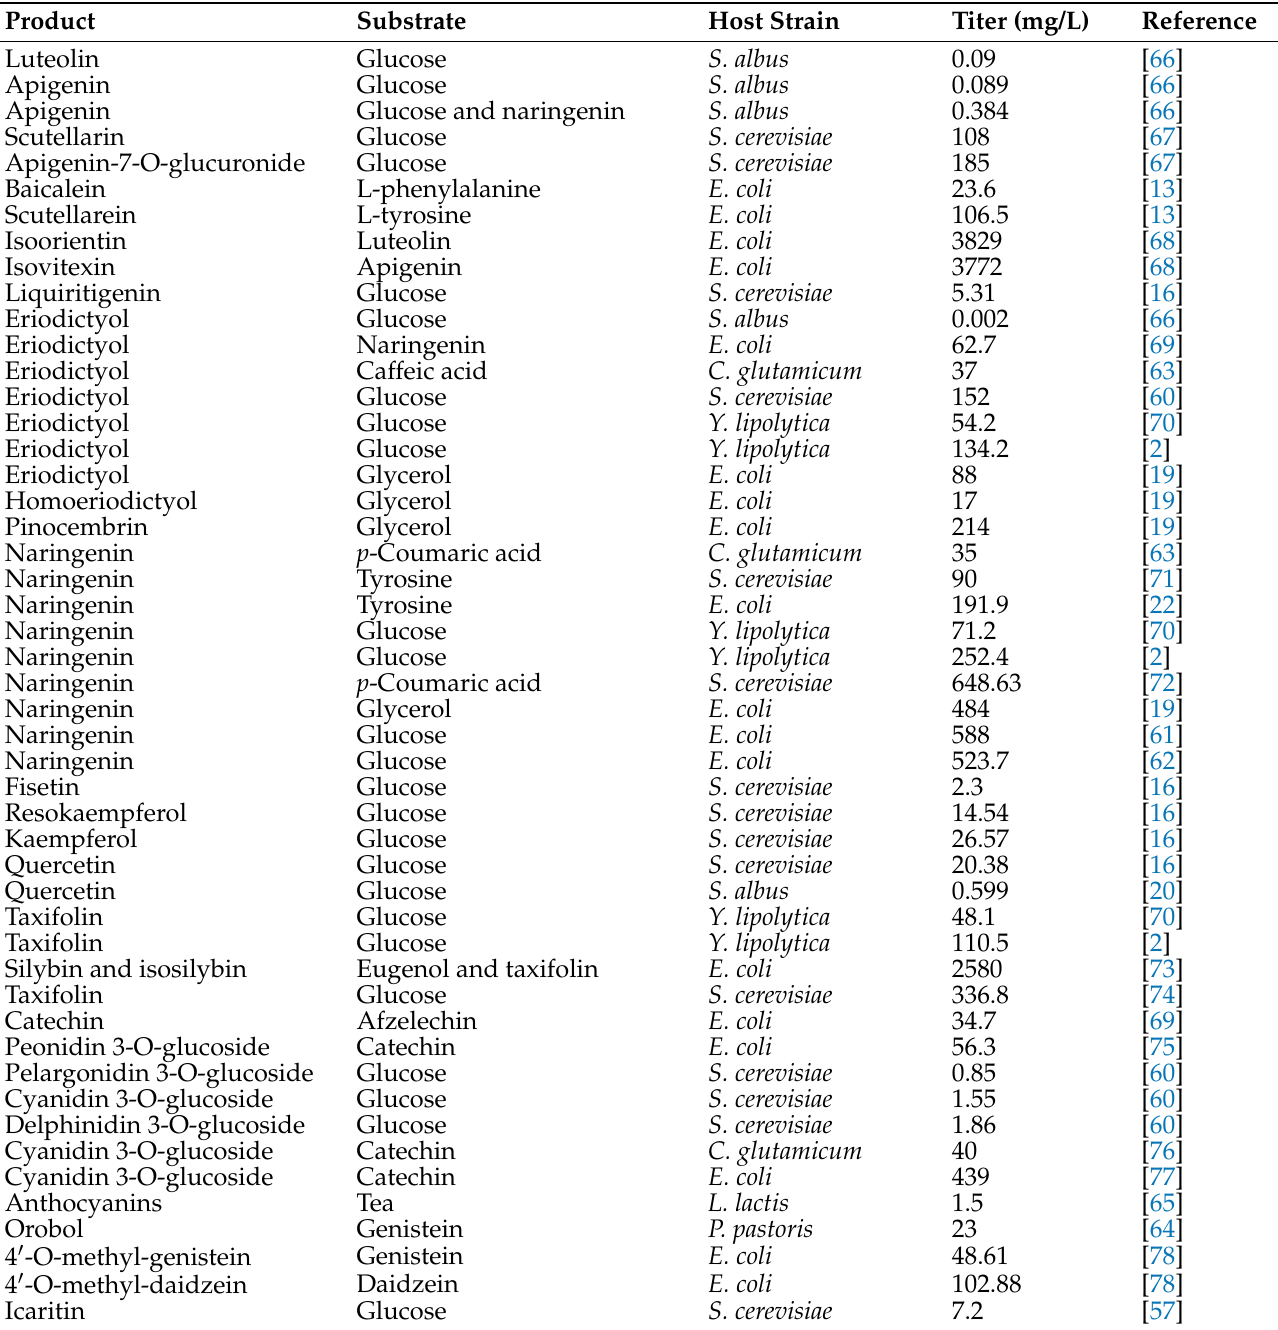
Table 2. Microbial mono-culture for the production of flavonoids in the past five